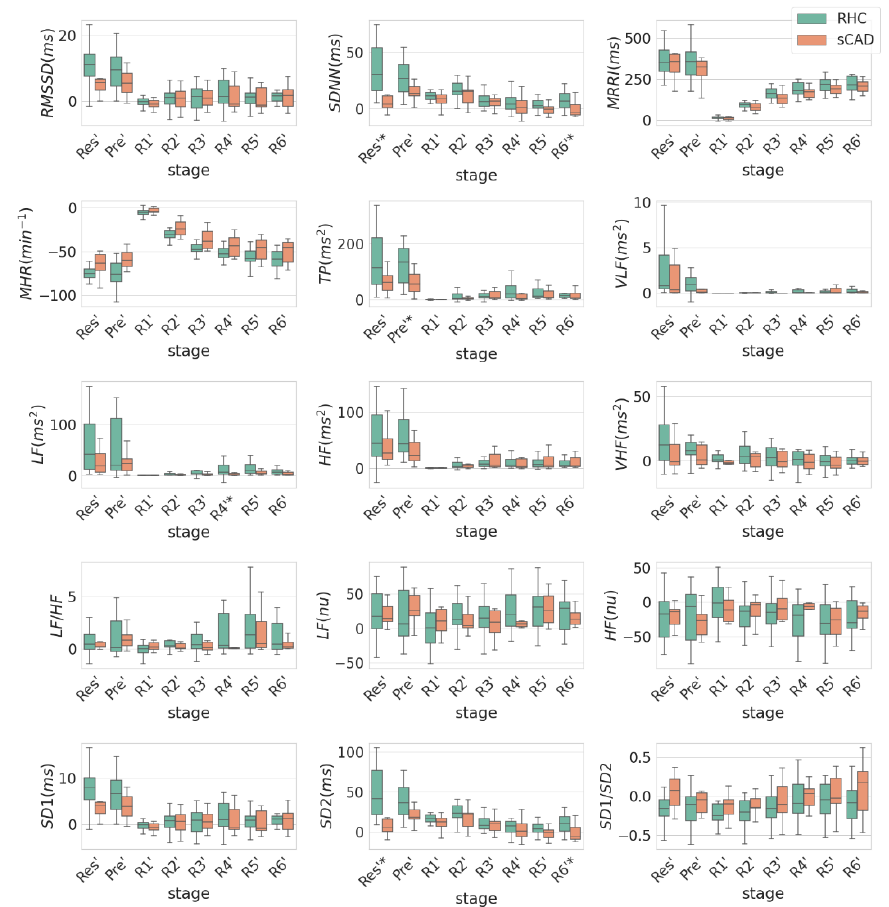
Figure 2. The box plot of the difference in the value of each HRV index between each stage and the Max stage. Each stage has a prime labeling. The symbol * indicates a significant difference at the 0.05 level ( p < 0.05).